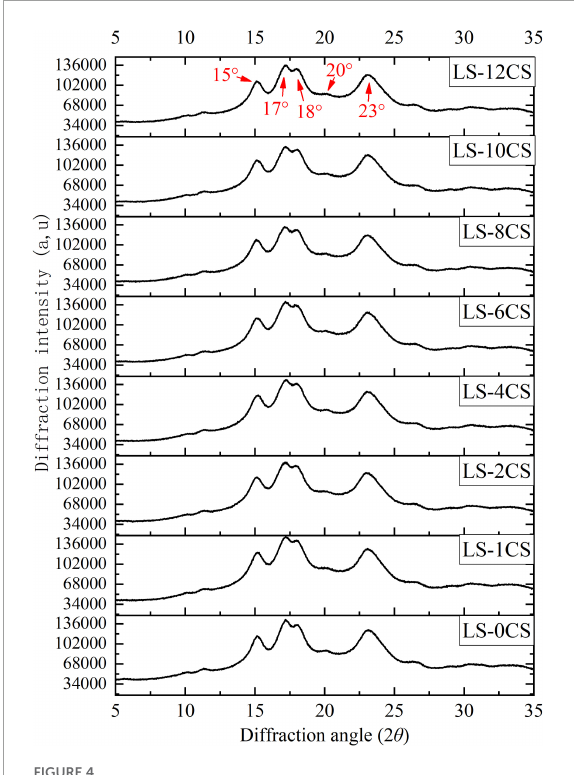
FIGURE4 X-ray diffraction patterns of lotus seed cross-linked resistant starch